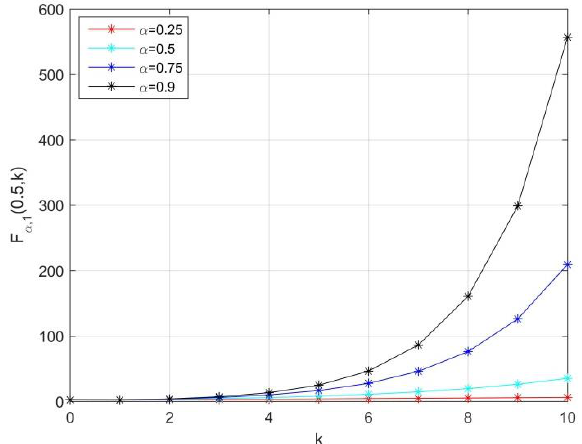
Figure 1. Trend of the discrete Mittag-Leffler function F α ,1 ( 0.5, k )